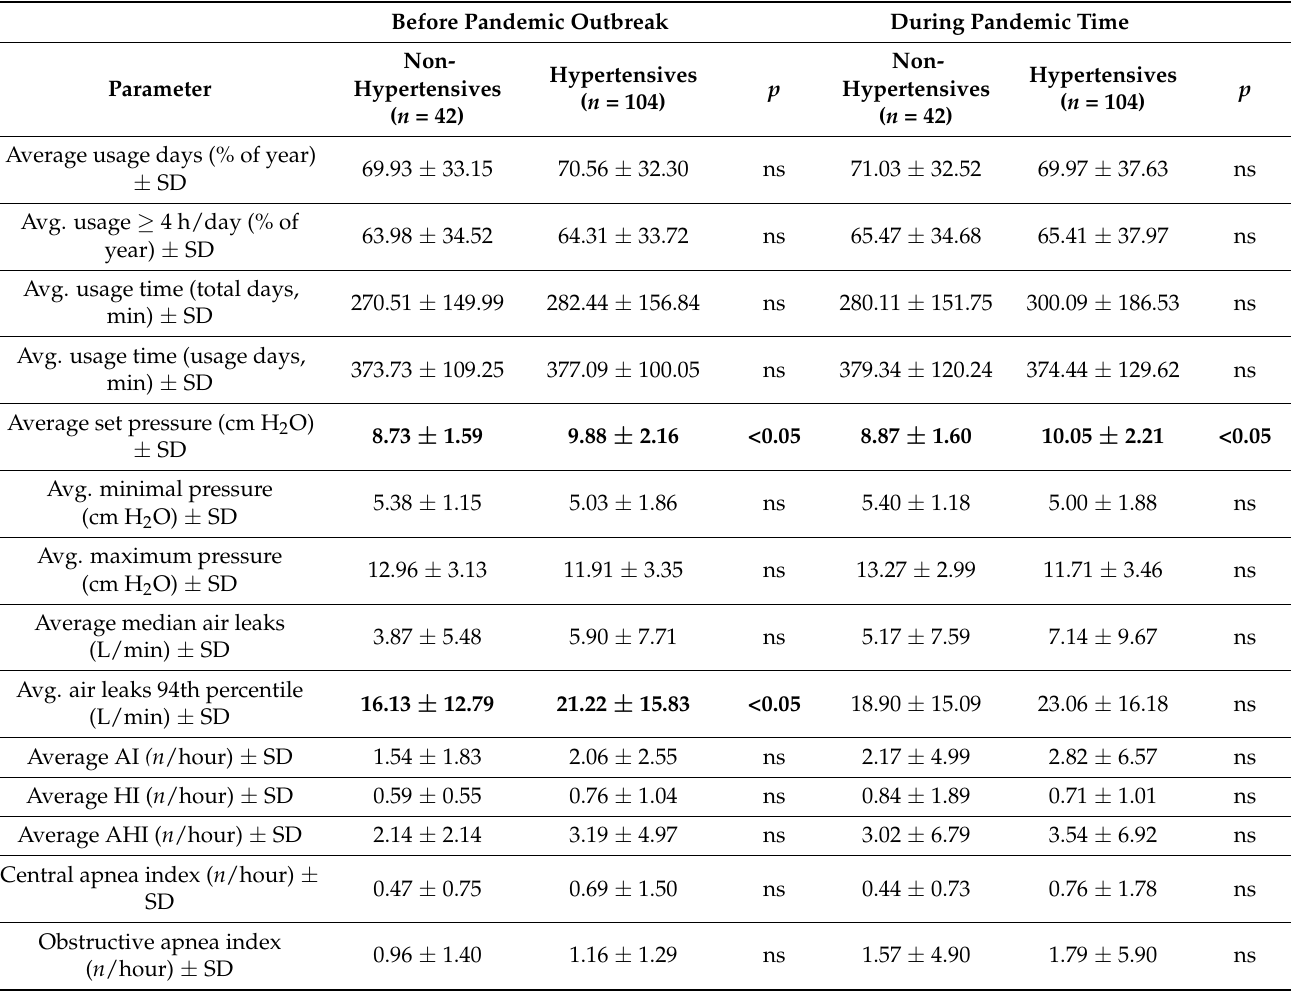
Table 5. CPAP therapy parameters and therapy adherence of hypertensive and non-hypertensive study participants before pandemic outbreak during first year of pandemic time. Before Pandemic Outbreak During Pandemic Time